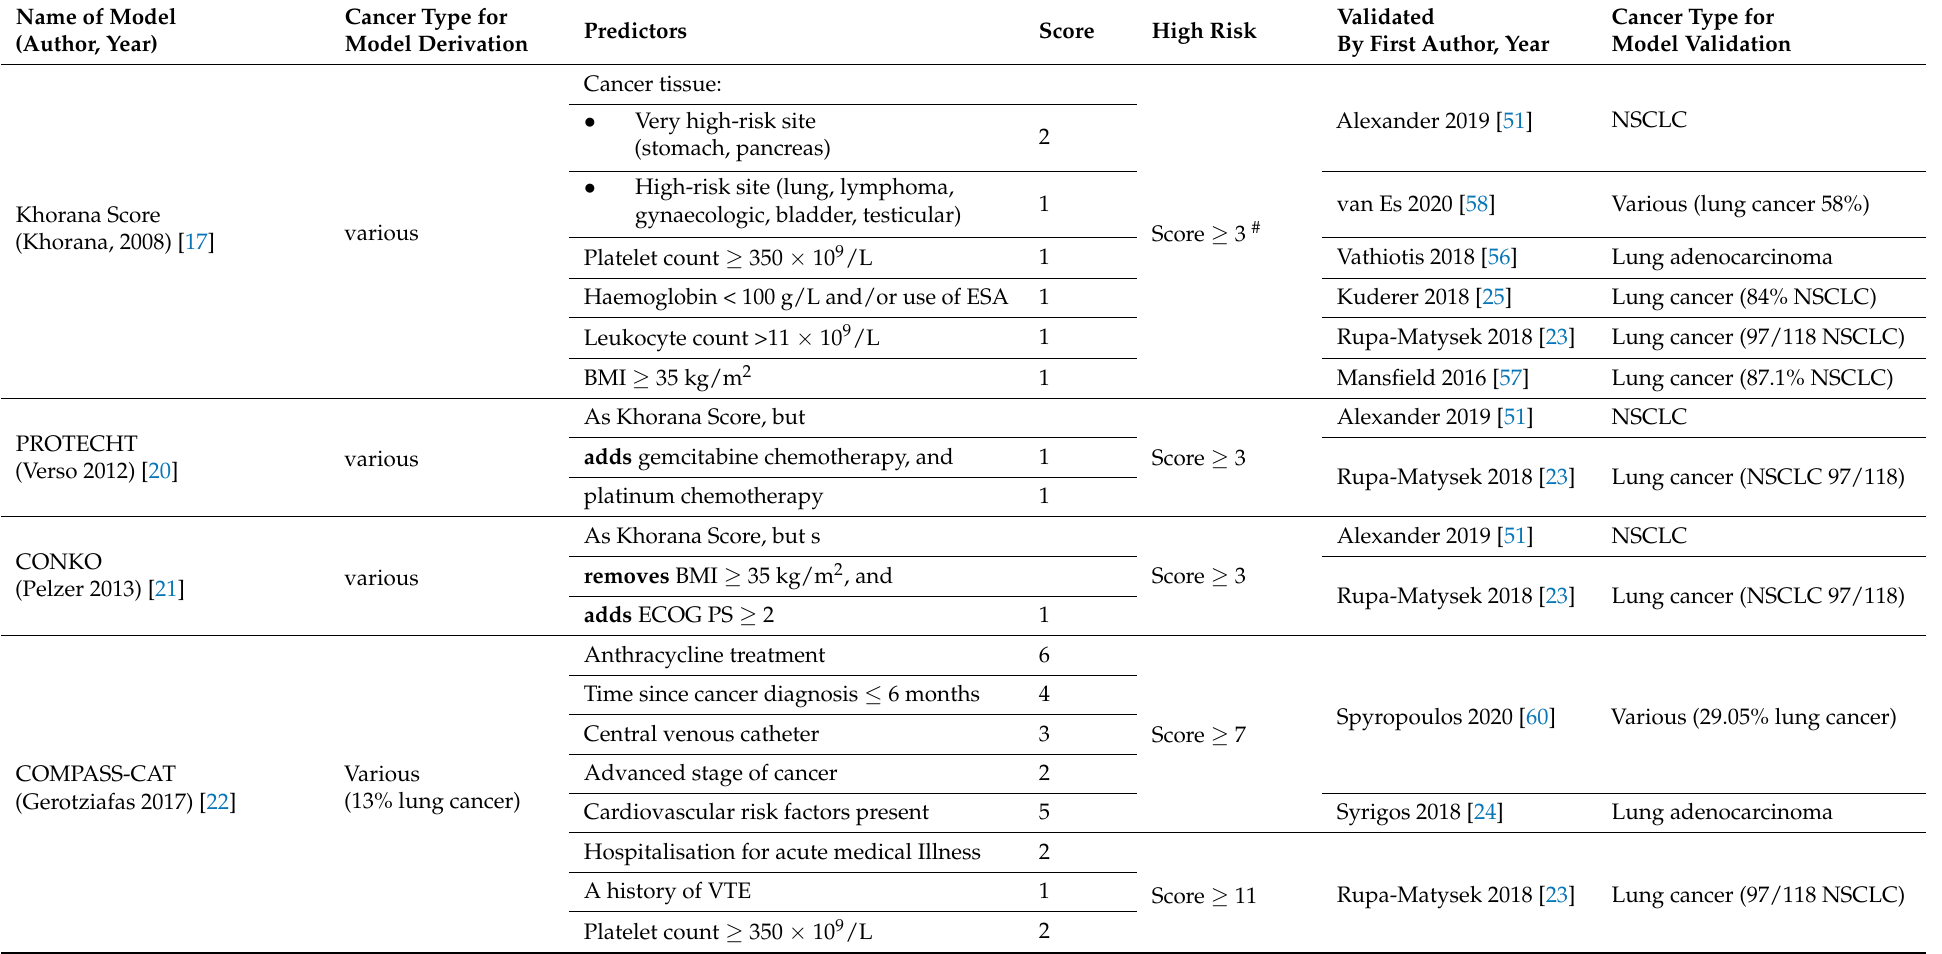
Table 1. Models for predicting VT E in ambulatory patients with lung cancer